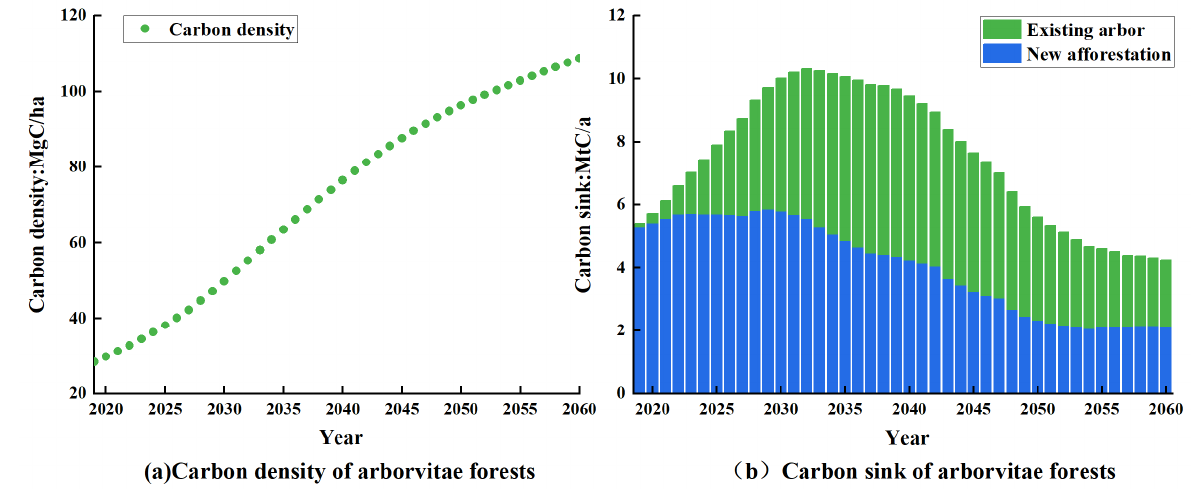
Figure 7. All arborvitae forests’ carbon density and carbon sink in Henan Province, 2019–2060.